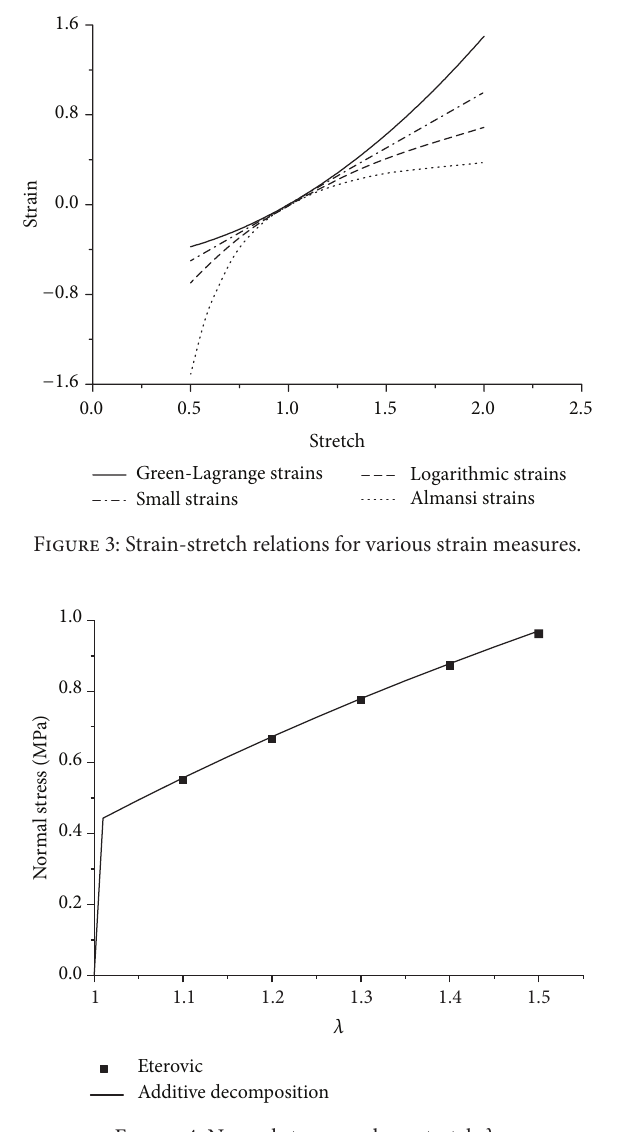
Figure 4: Normal stress 𝜎 𝑥 along stretch 𝜆 .